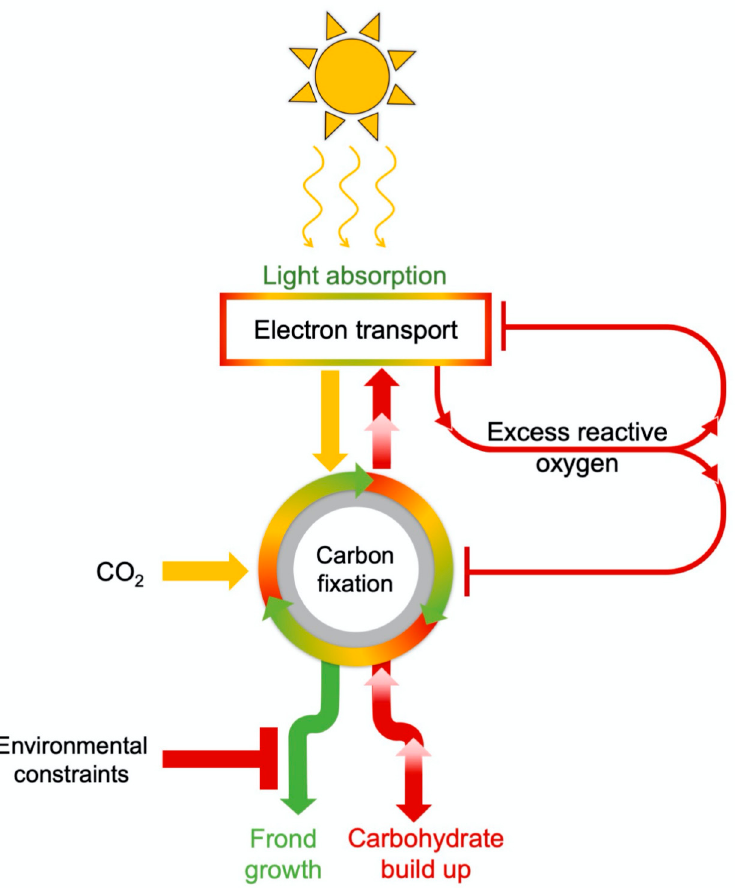
Figure 6. Schematic depiction of the effect of environmental inputs (light, CO 2 , and factors that limit leaf/frond growth) in triggering feedback inhibition of photosynthesis via repression of photosyn- thetic genes when carbohydrate builds up in leaves/fronds because of limiting sink